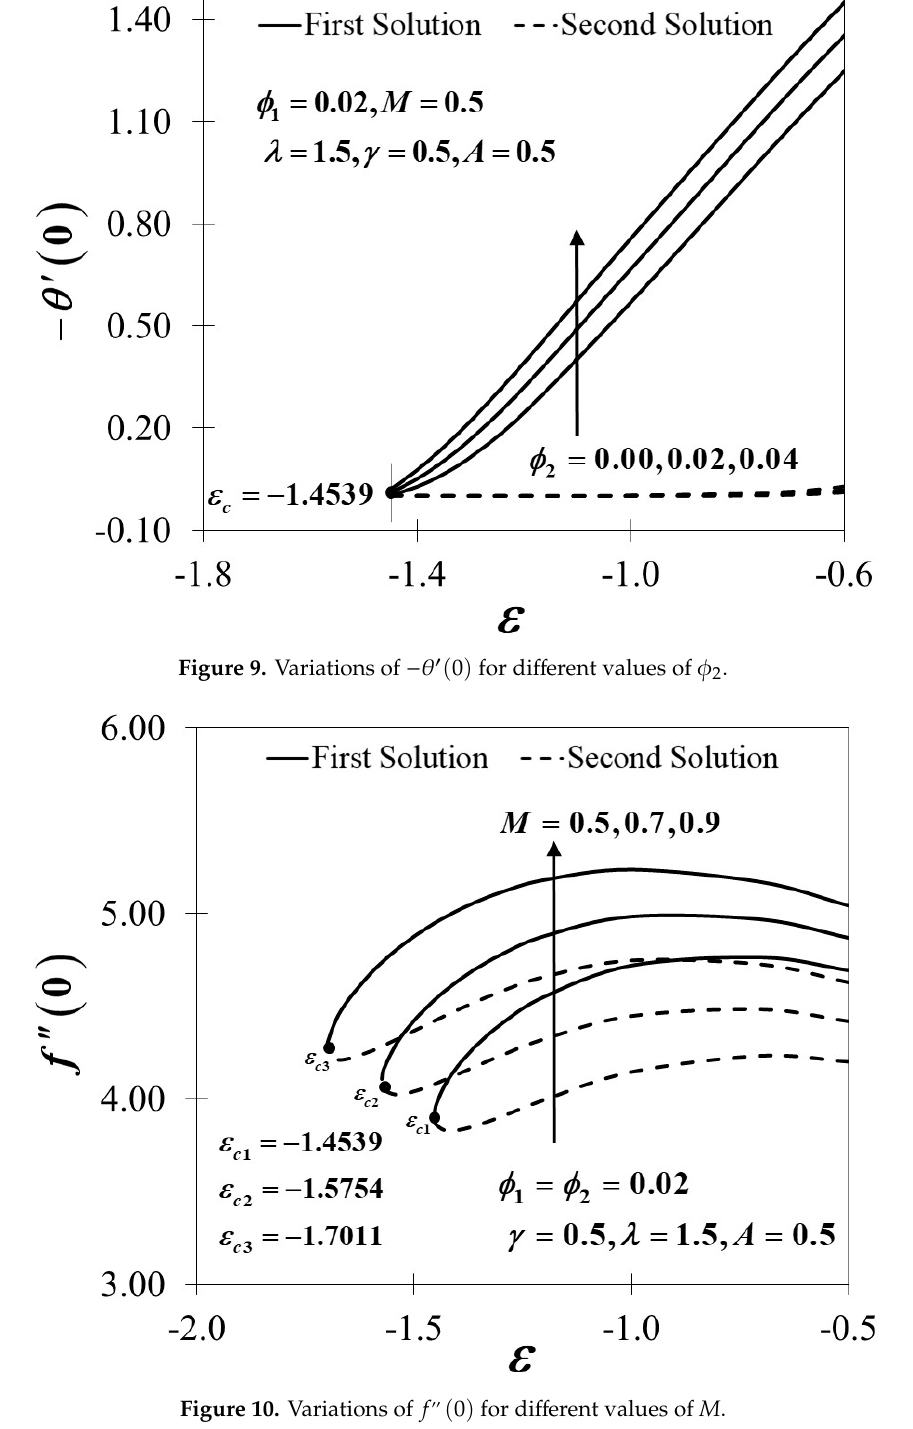
Figure 10. Variations of f ′′ (0) for different values of M .